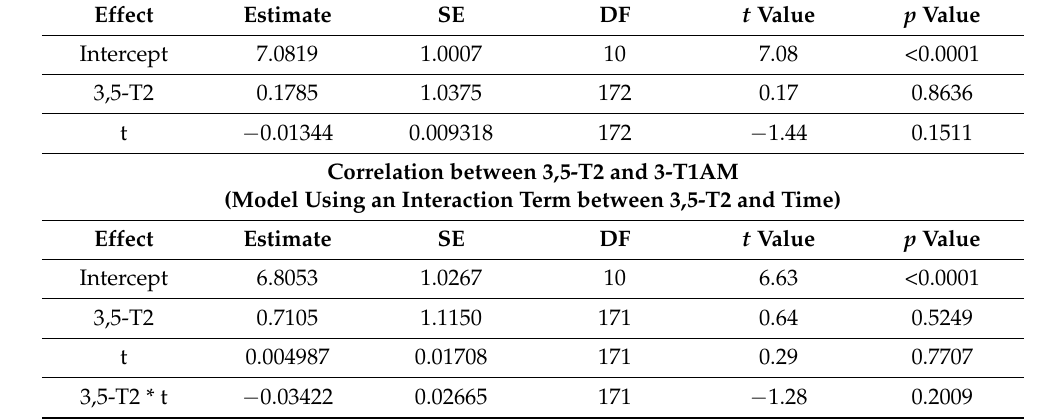
Table 2. Correlations between 3,5-T2 and 3-T1AM concentrations in the healthy volunteers. (* = interaction term).